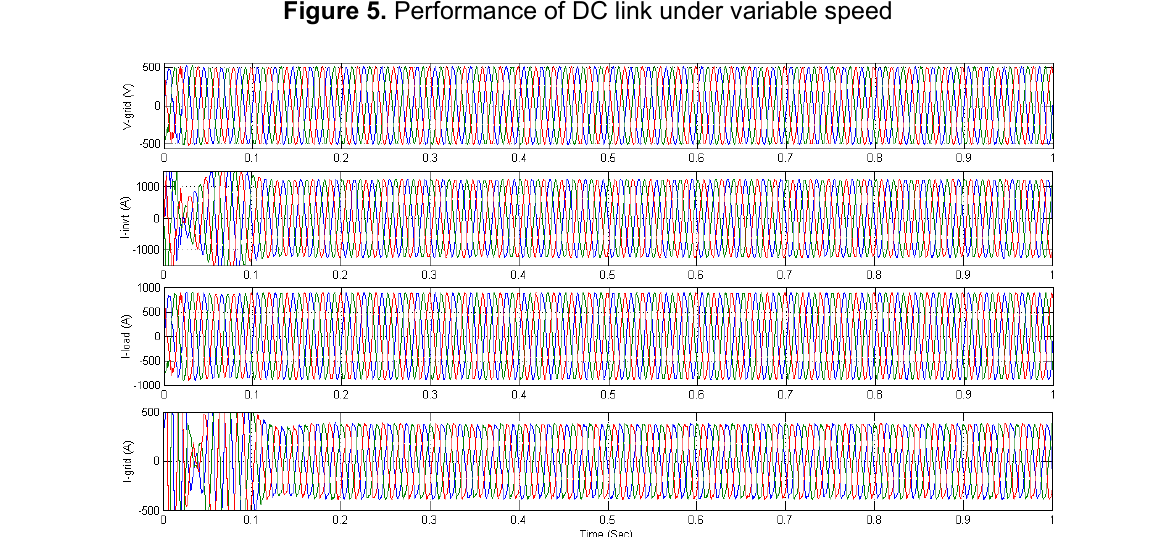
Figure 5. Performance of DC link under variable speed